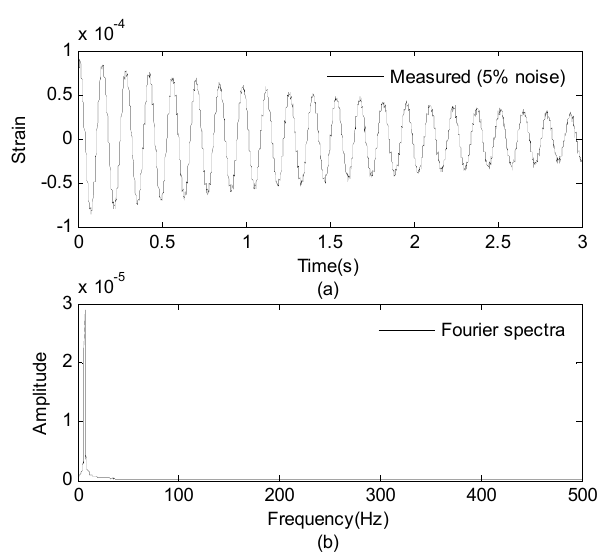
Figure 8. Strain measurement data and Fourier spectra of the data. ( a ) Strain measurement data (0–3 s); and ( b ) Fourier spectra of the measurement data (0–3 s). Sensors 2016 , 16 , 1290